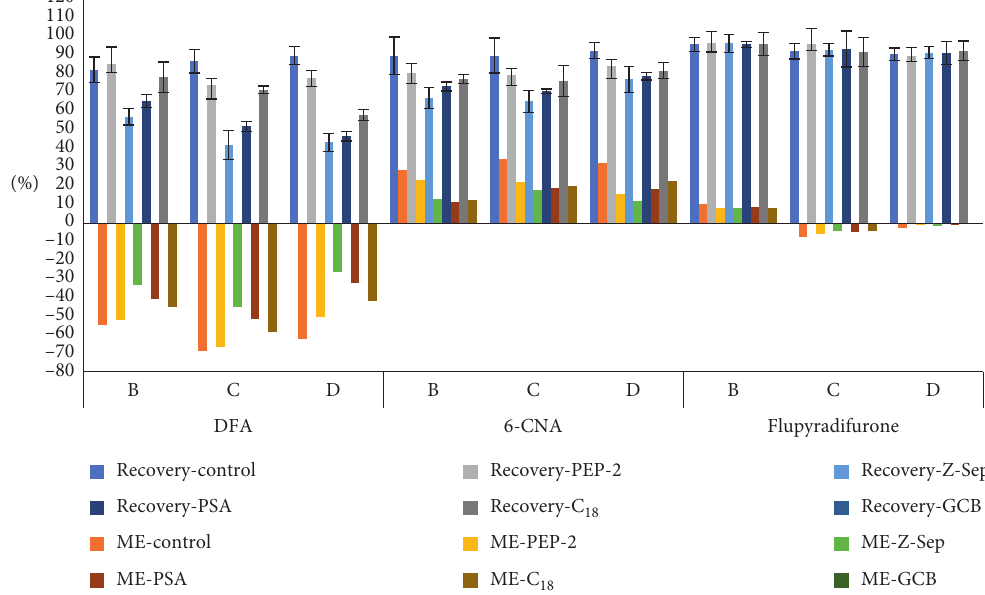
Figure 6: Recovery and ME of flupyradifurone, DFA, and 6-CNA for the method under different combinations of sorbent conditions ( n � Table 1: Calibration information of target compounds in the range of 0.01–1 mg/L in different matrices. Compound Matrix Calibration equation